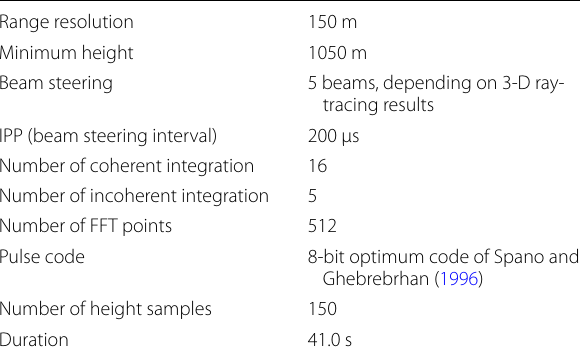
Table 3 Radar parameters for the RASS measurements with